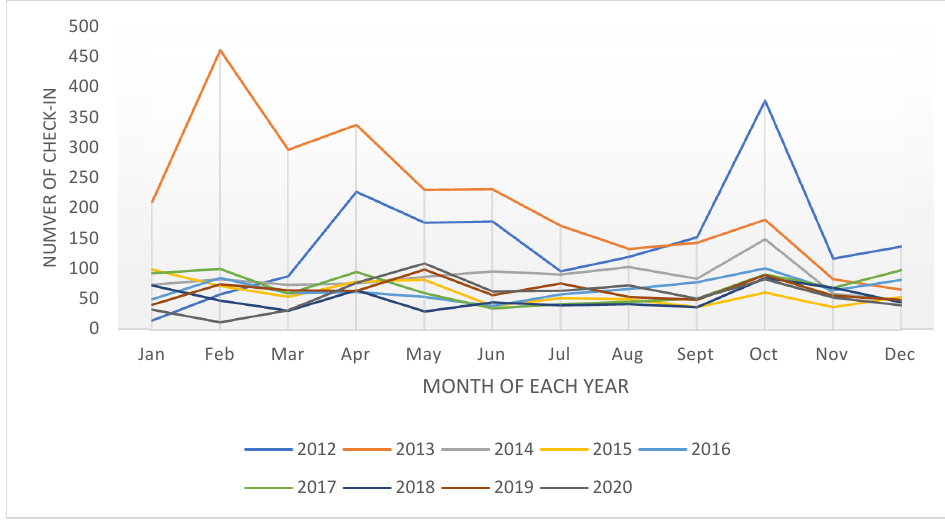
Figure 4. The changes of Fengjing Ancient Town’s Sina Weibo check-in data during the 2012 to 2020 period (source: authors).